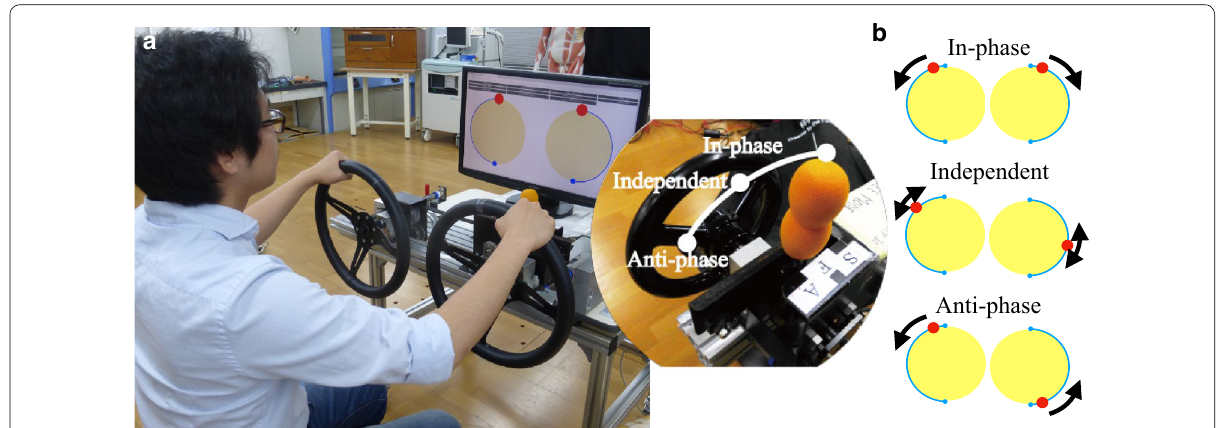
Fig. 1 a Dual-steering rehabilitation system, the wheels of which can be mechanically uncoupled or coupled. b The movement patterns performed in the experiments: in-phase, where hands move in opposite directions; and anti-phase, where hands move in the same direction